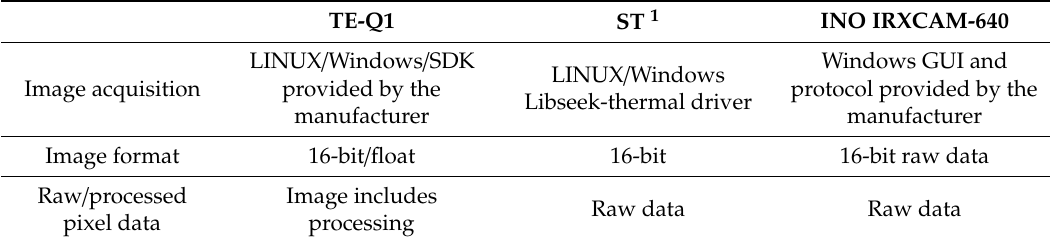
Table 4. Summary of camera characteristics according to preliminary